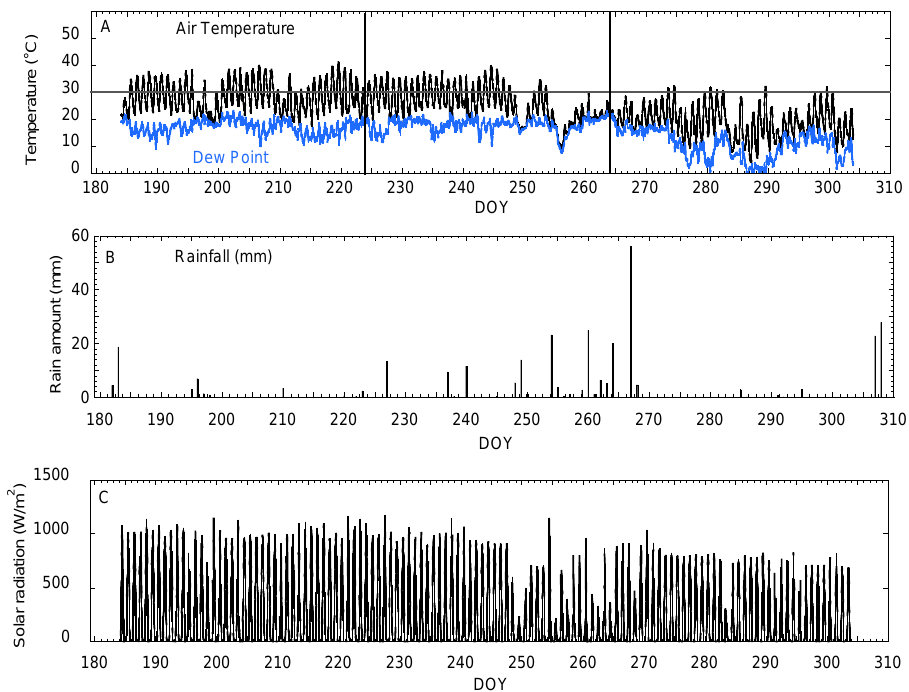
Figure 1. Air temperature and dewpoint (15 min) ( A ), rain (daily) ( B ), and solar radiation (15 min) ( C ) over the 120-day study interval collected by a weather station at the field